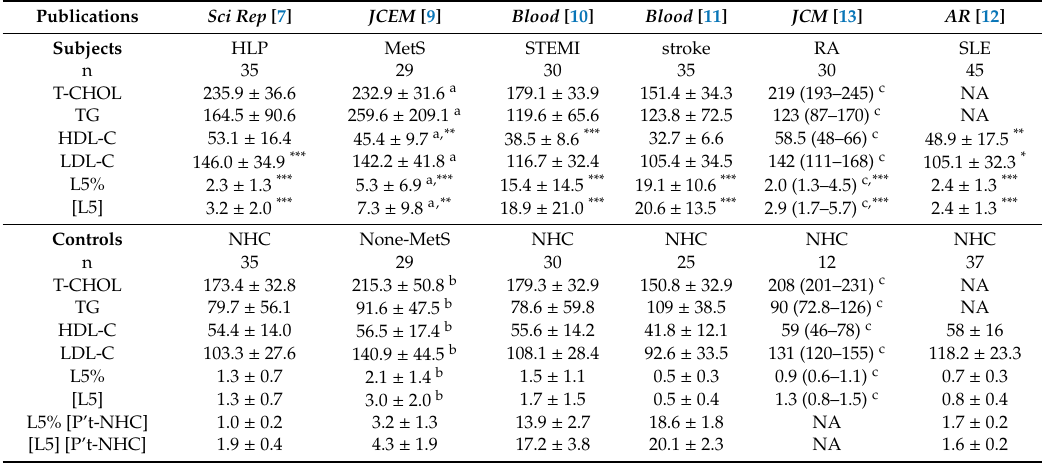
Table 1. Clinical significance of electronegative low-density lipoprotein (L5 LDL)–data collected in